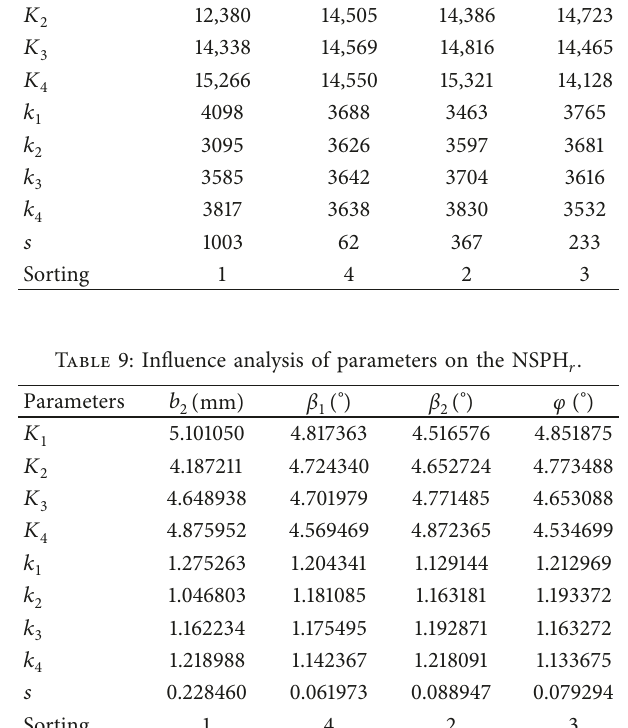
Table 8: Influence analysis of parameters on the shaft power. Parameters